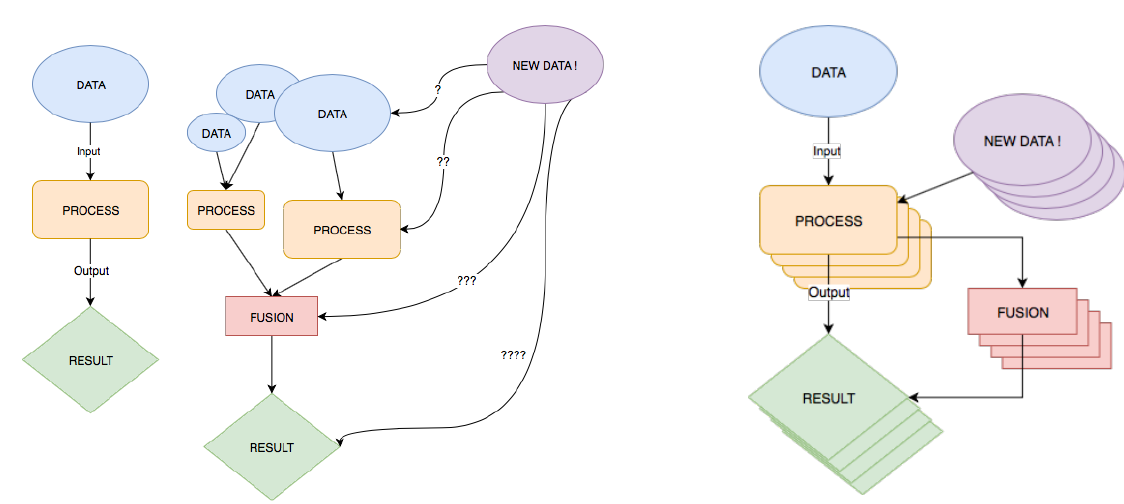
Figure 1: Current state and problematic of manual multimodal CRP data processing